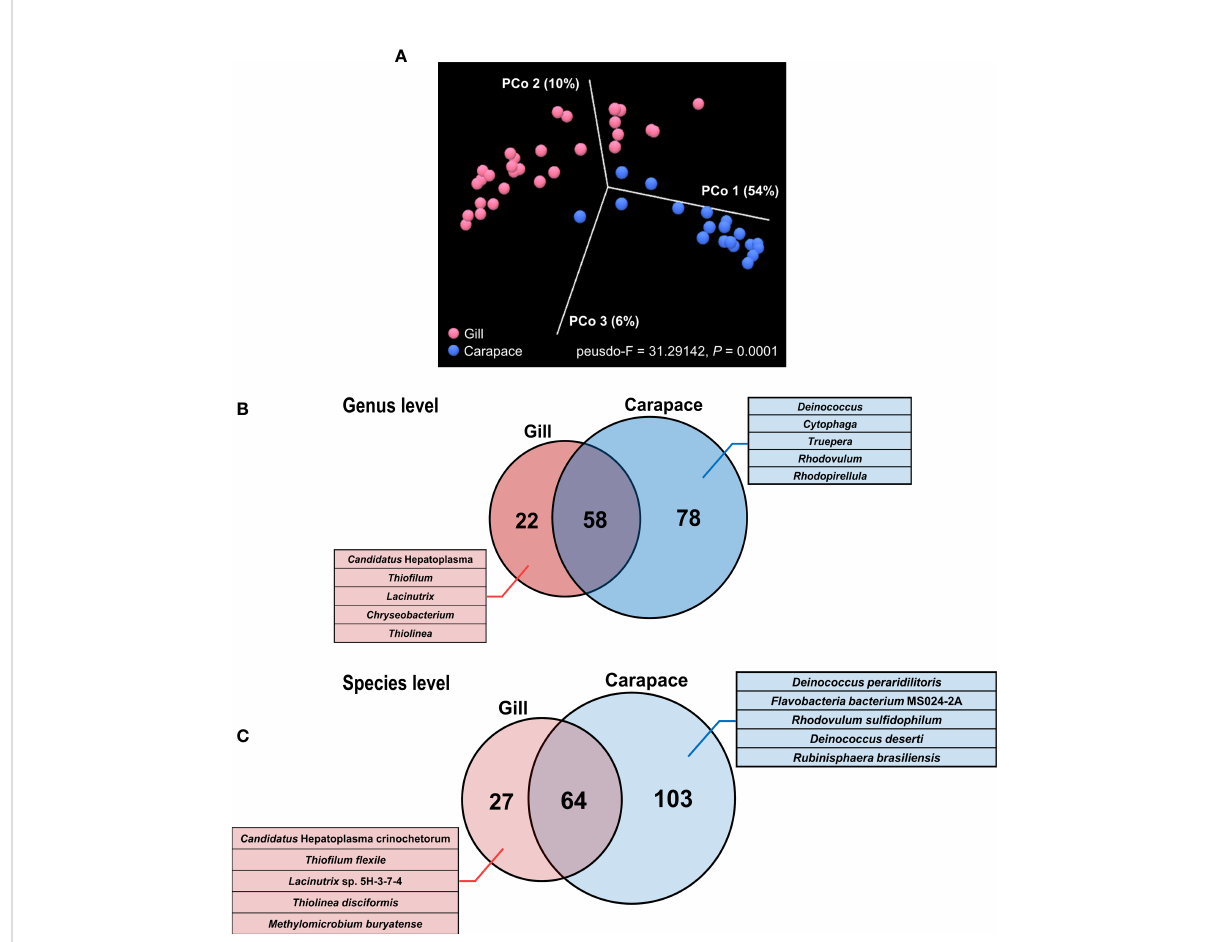
FIGURE 4 Principal coordinate analysis (PCoA) and Venn diagram of gill and carapace bacterial communities. PCoA was performed at the species level based on the Bray-Curtis distance, revealing the relative dissimilarity in bacterial community structures between the gill and carapace surface (A) . The Venn diagram shows the distributions of bacterial genera (B) and species (C) . Numbers of identi fi ed shared or speci fi c groups are shown. For gills and carapace, the fi ve most abundant speci fi c genera and species are